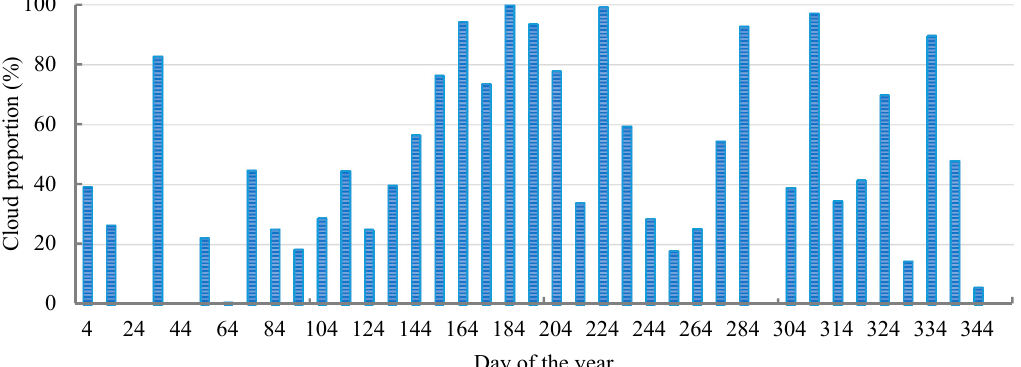
Figure 5. Cloud coverage of time-series Sentinel-2 imagery in the study area in 2017.